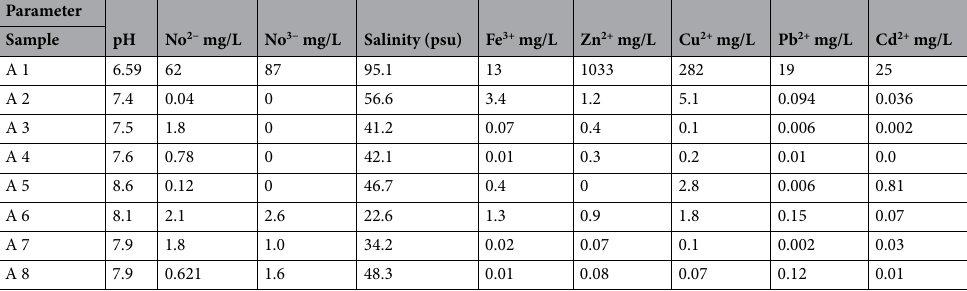
Table 1. Chemical analyses of water samples.